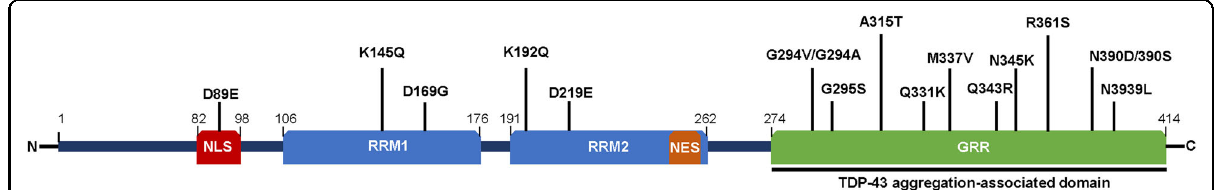
Fig. 1 Schematic representation of the structure and aggregation-associated mutations of TDP-43. The TDP-43 protein contains a nuclear localization signal (NLS), 2 RNA-recognition motifs (RRM1 and RRM2), a nuclear export sequence (NES), and a glycine-rich region (GRR). Numerous disease-associated TDP-43 mutations have been identi fi ed in the GRR. Most disease-associated TDP-43 missense mutations have been identi fi ed to accelerate TDP-43